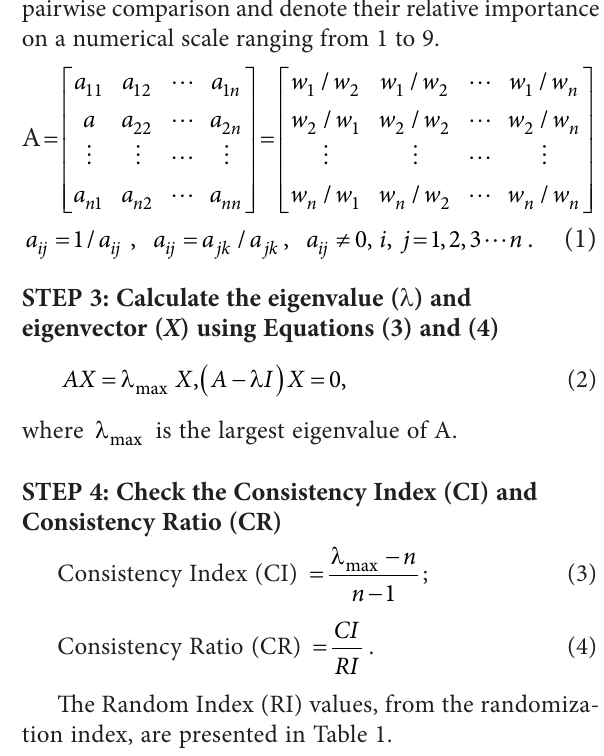
Table 1. Randomization index values (Satty, 1990)